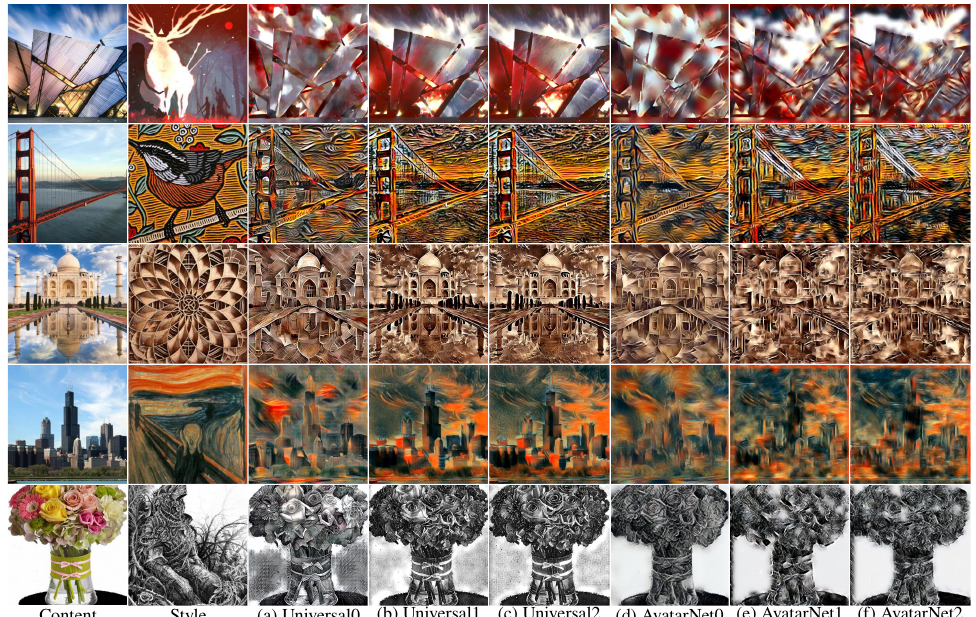
Figure 4. Comparison of the output image of existing style transfer methods (Universal [3] ( a ), AvatarNet [4]) ( d ), results of the end-to-end learning scheme [41] ( b , e ), and the results of our method ( c , f ): the output images were generated using the images not used during the network